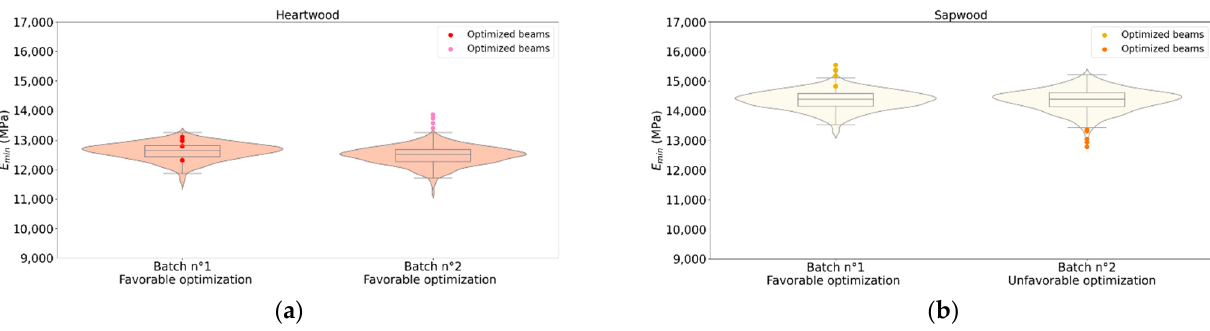
Figure 10. E mini between loading points according to cases: ( a ) heartwood batches, ( b ) sapwood batches.